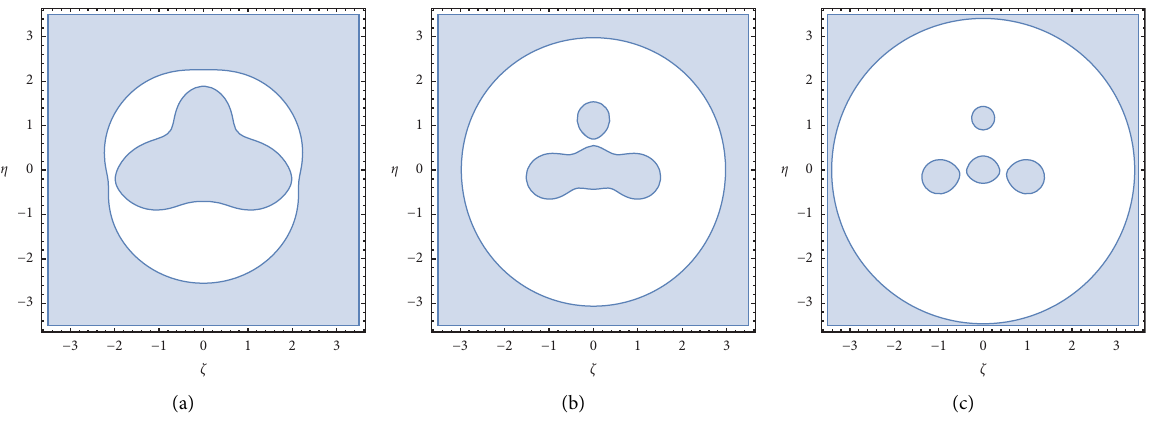
Figure 8: Case II: regions of motion for m